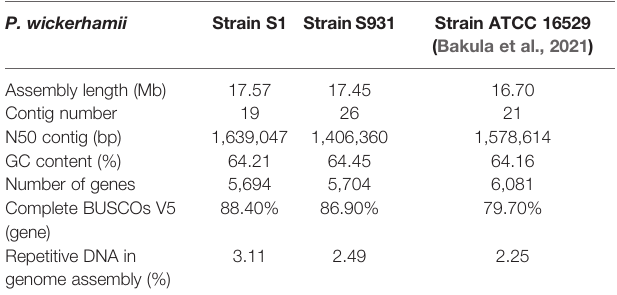
FIGURE 1 | Characteristics of the two types of P. wickerhamii genomes. Distribution of genomic features of the P. wickerhamii genomes for strain S1 (red) and strain S931 (green). From inside to outside: (A) syntenic gene blocks, (B) GC content, (C) TE density, (D) gene number, (E) gene length, and (F) Contig (>500 kb). TABLE 1 | Genome statistics of two newly sequenced and one published P. wickerhamii